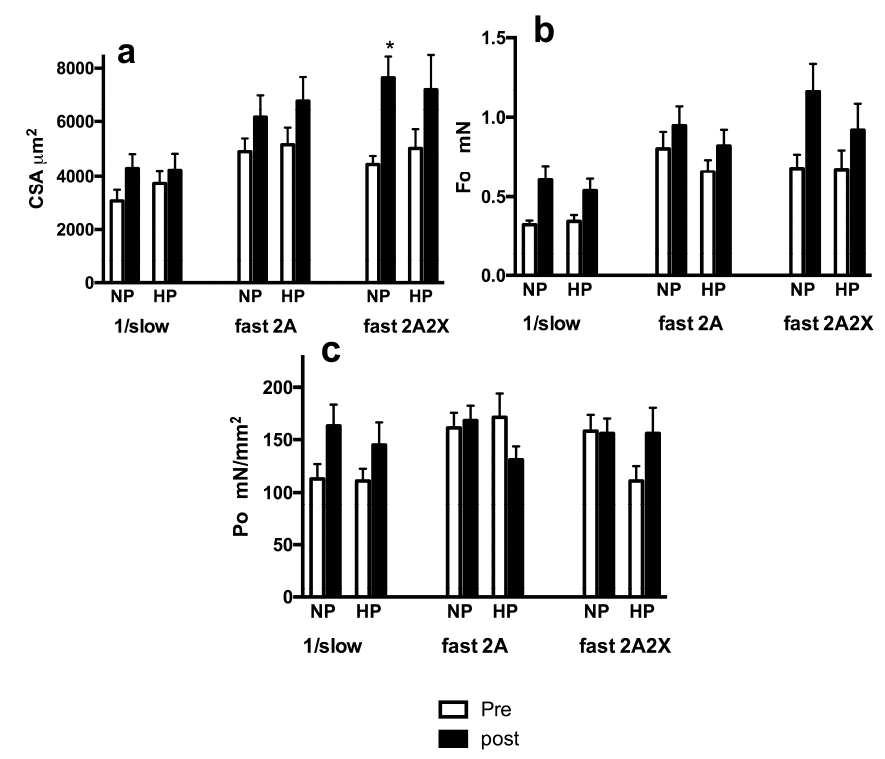
Figure 6. Response of individual fiber types, classified on the basis of their MyHC isoform composition and treatment (HP vs. NP) to RT training. Means and Standard Errors. Significant difference between post- and pre-training * p <